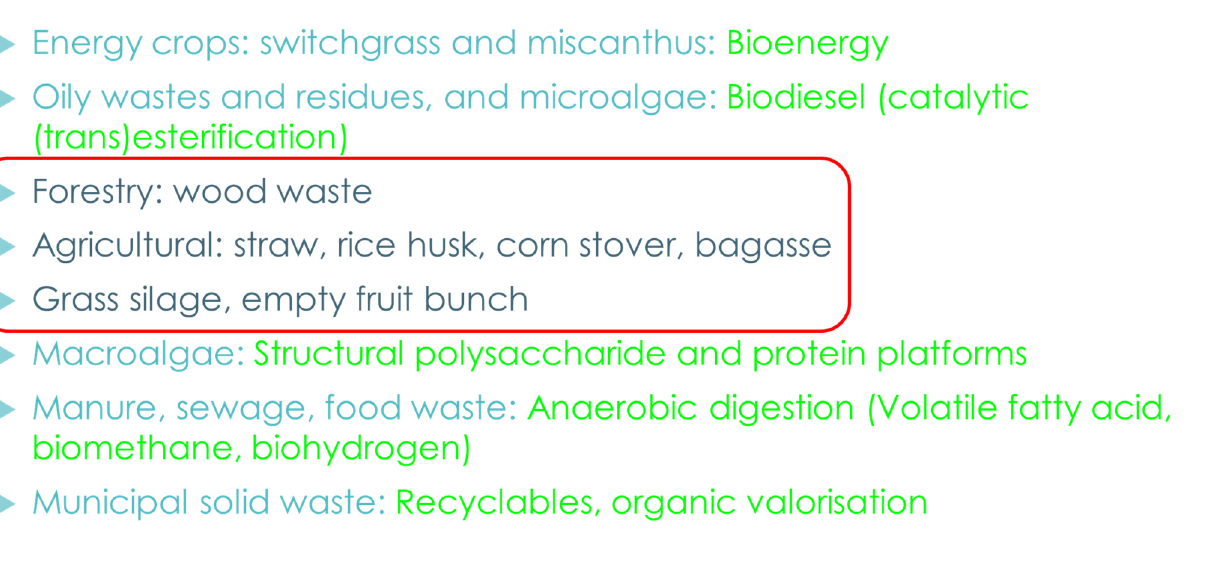
Figure 6. Biomass resources and biorefinery process and product options.